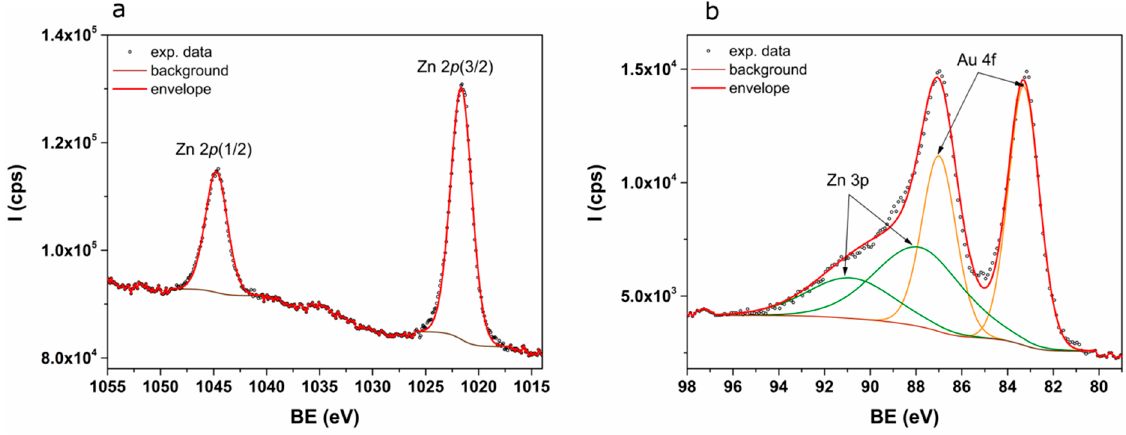
Figure 5. XPS spectra of core-level lines, corresponding to Zn 2p ( a ) and Au 4f and Zn 3p ( b ).